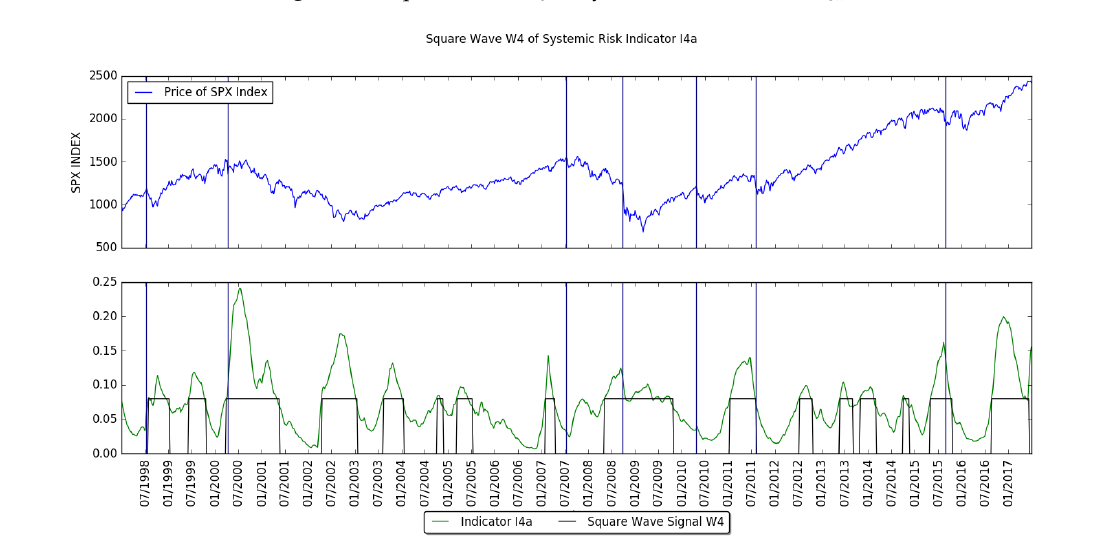
Figure 14. Square Wave W 3 of Systemic Risk Indicator I 3 a .